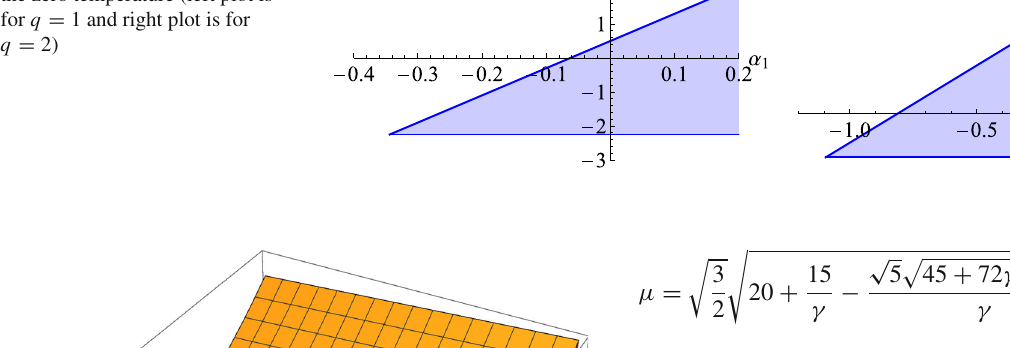
Fig. 4 The blue zone is the allowed region for the superconducting phase transition at m 2 vs α 1 plane at the zero temperature (left plot is for q = 1 and right plot is for